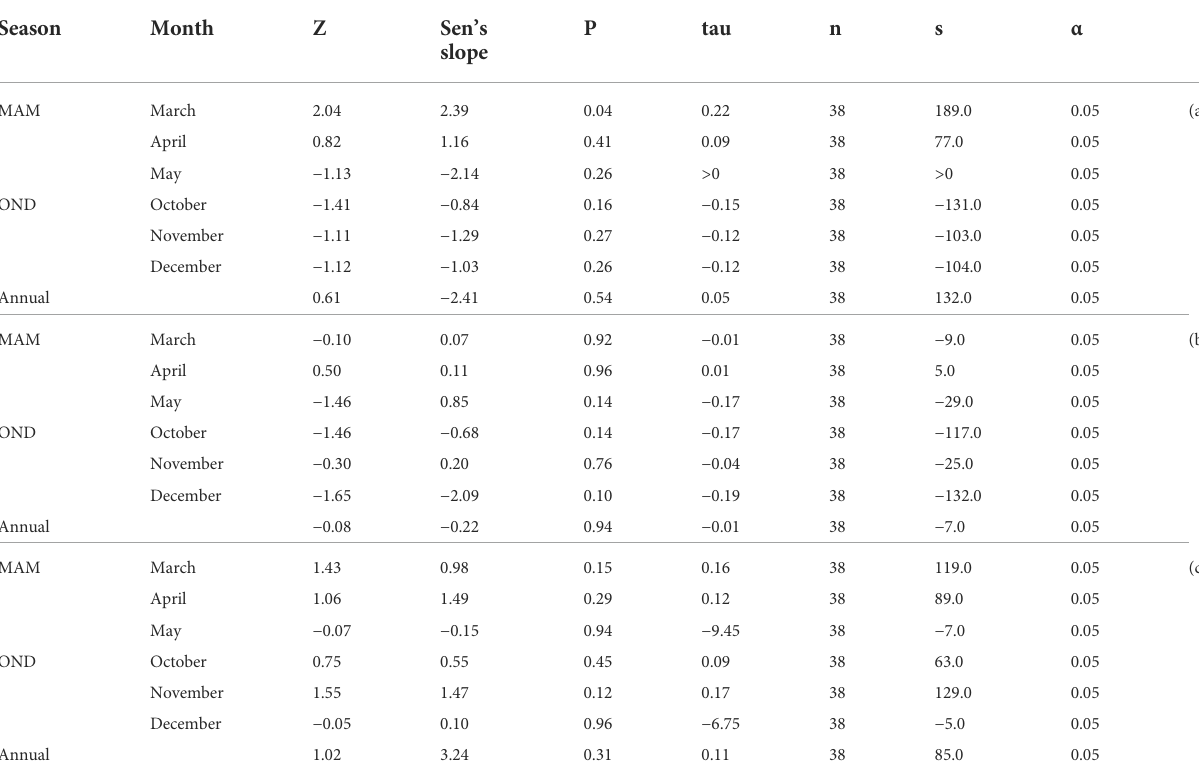
TABLE 4 Mann – Kendall statistical results of (a) Julius Nyerere International Airport (b), Port Met station, and (c) Chanika.